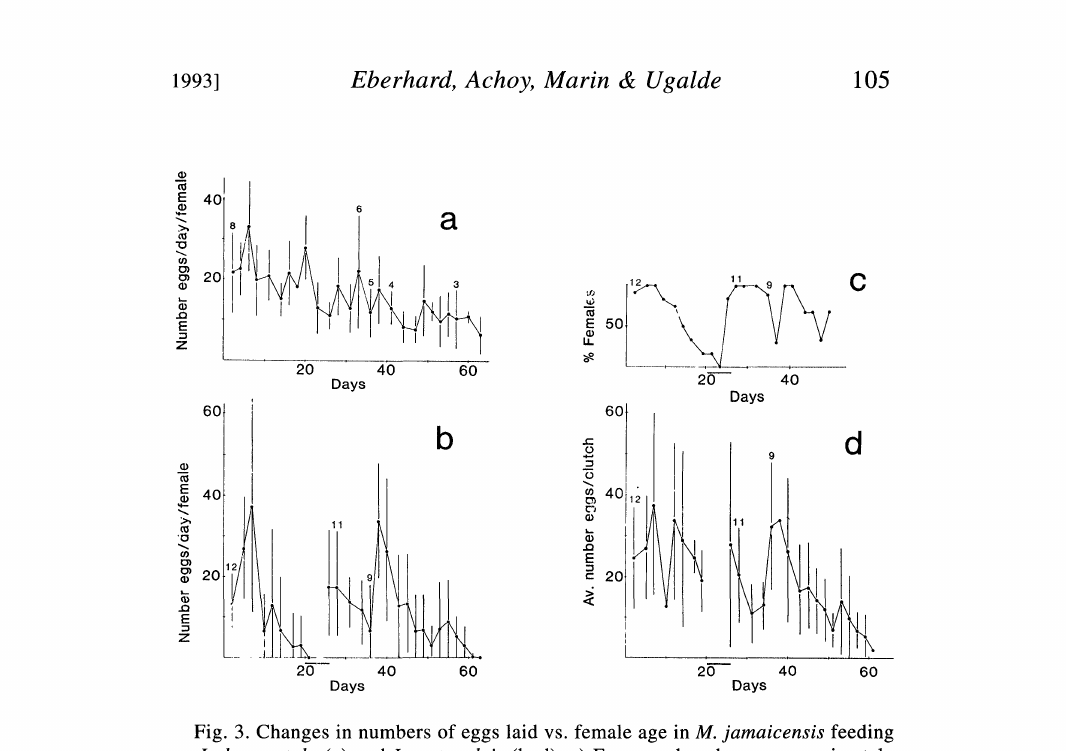
Fig. 3. Changes in numbers of eggs laid vs. female age in M. jamaicensis feeding on L. hexapetala (a) and L. octovalvis (b-d). a) Eggs produced over approximately two months with continuous access to males (small numbers indicate numbers of females when they changed due to death or loss) (vertical bars are standard devia- tions), b) Eggs produced after a pair of copulations occurred before the first ovipo- sition, then the female was isolated until day 20 when she was kept with a male for 3 days (horizontal bar) before being isolated again, c) Numbers of females oviposit- ing during the experiment described in b). d) Numbers of eggs laid during the experiment described in